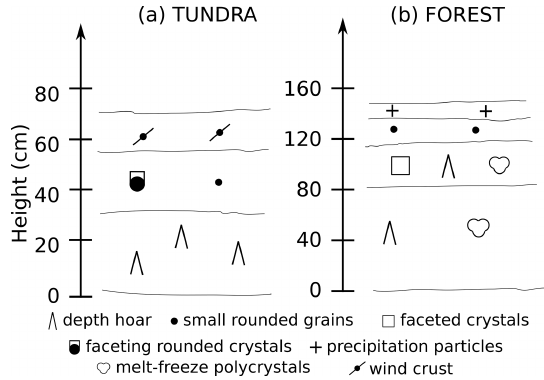
Figure 5. Simplified stratigraphies from February 2014 represent- ing typical snow conditions at sites (a) TUNDRA (25 February) and (b) FOREST (28 February). Note that the y scales are different for the two